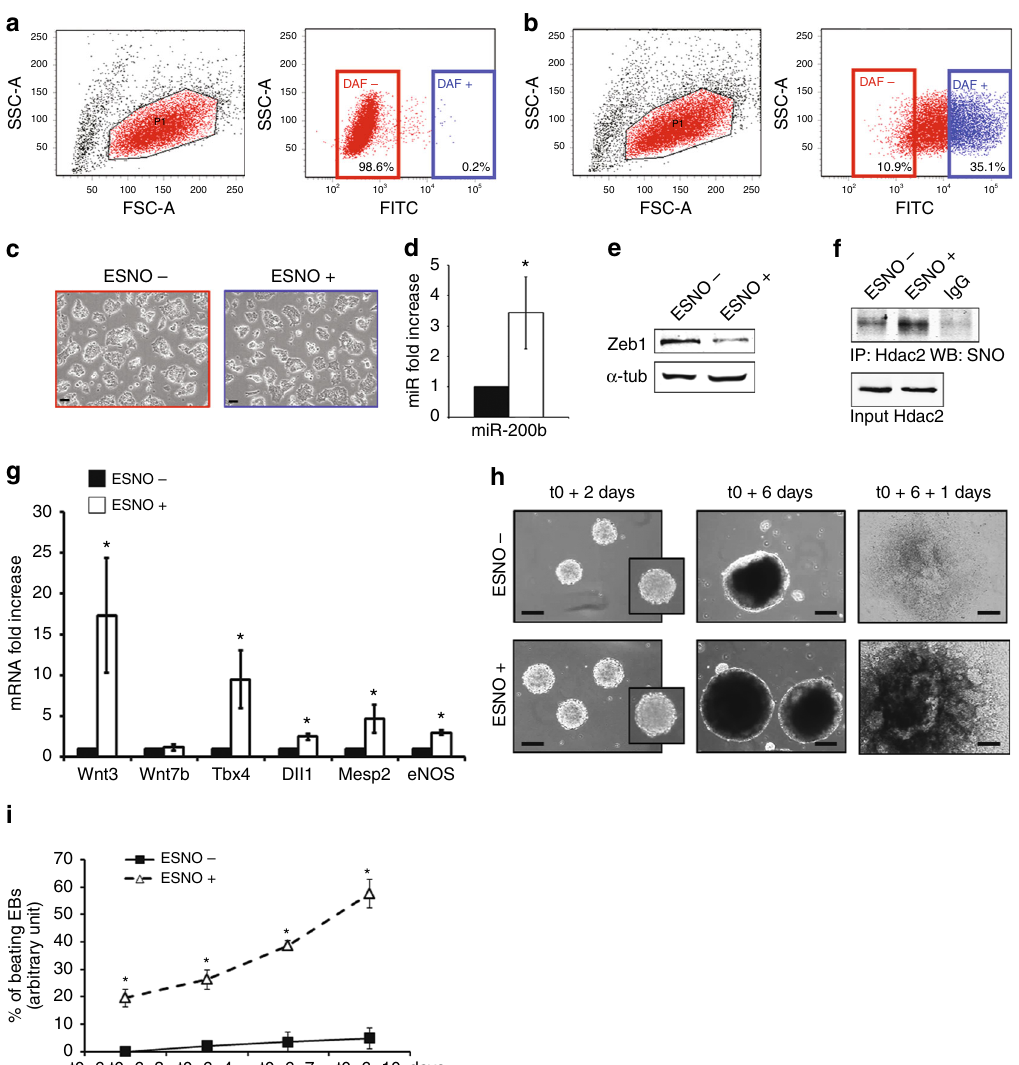
Fig. 6 ESNO + / − subpopulation isolation and characterization. a , b FACS analysis. a Left: representative scatter plot showing forward (FSC-A) and side scatter (SSC-A) distribution in GS. Right: representative dot plot showing the fl uorescein isothiocyanate (FITC) and SSC-A distribution in GS in the presence of DAF fl uorescent probe. b Same as a related to 2 h DM. Each experiment: gating to separate ESNO + (DAF + ; blue dots) from ESNO − (DAF − ; red dots) established manually ( n = 3). c Representative phase contrast microscopy images of ESNO − (red upper panel) and ESNO + (blue lower panel) cultured in DM. Scale bar 10 µ m. d miR-200b expression analysis in ESNO + (white bar) compared to ESNO − (black bar) at 24 h from sorting. Data shown as mean ± s.e.m. represented as fold increase compared to ESNO − after subtraction of the housekeeping gene p0 signal (* p < 0.05; n = 3). e Representative WB of Zeb1 in ESNO + and ESNO − at 24 h from sorting ( n = 3). Full-length blot provided in Supplementary Fig. 11a. f Representative IP/WB analysis of Hdac2 S-nitrosylation in ESNO + and ESNO − after sorting ( n = 3). Full-length blot provided in Supplementary Fig. 11b. g Wnt3, Wnt7b, Tbx4, Dll1, Mesp2, and eNOS expression analysis in ESNO + (white bars) compared to ESNO − (black bars) at 24 h from sorting. Data shown as mean ± s.e.m. represented as fold increase compared to ESNO − after subtraction of the housekeeping gene p0 signal (* p < 0.05; n = 3). h Phase contrast microscopy images of ESNO − and ESNO + derived EBs (upper and lower panels, respectively) taken at different stages of the EB formation process after sorting (t0): 2 and 6 days of hanging drop culture after t0 (t0 + 2 and t0 + 6, respectively) and the fi rst day after plastic adherence following hanging drop culture (t0 + 6 + 1). Scale bar 30 µ m. i Quanti fi cation of beating EBs generated by ESNO + (open triangles) and ESNO − (closed squares) upon a time course from three (t0 + 6 + 3) to ten (t0 + 6 + 10) days after plastic adherence (t0 + 6). Data expressed as mean ± s.e.m. (average total number of plated EBs/condition/ experiment = 48; * p < 0.05 ESNO + vs. ESNO − ; n = 4). Data analyzed by Kolmogorov-Smirnov test ( d , g ) and by 2 way ANOVA ( i